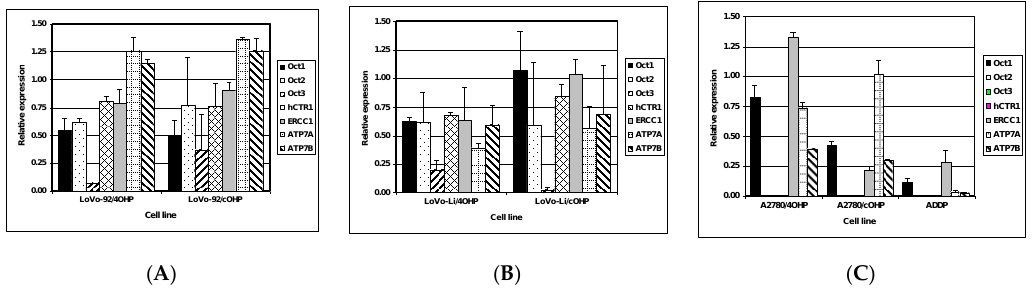
Figure 4. mRNA expression of transporters and DNA repair genes as determined by Q-PCR in ( A ) LoVo-92 variants, ( B ) LoVo-Li variants, and ( C ) A2780 variants. Values are means of two experiments in triplicate and are expressed relative to the house keeping gene β -actin.